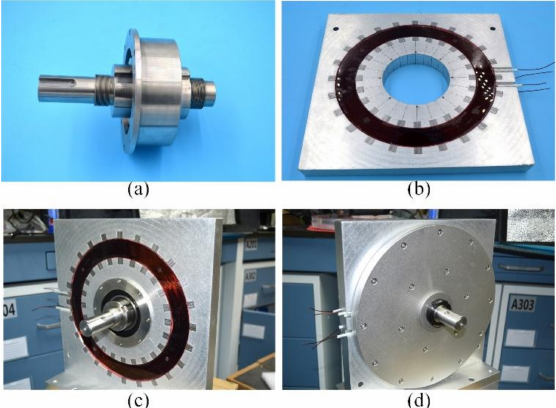
Figure 22. Assembly of the spindle and the generator: ( a ) Spindle; ( b ) Coil installation; ( c ) Assembly of the spindle; ( d ) The generator.